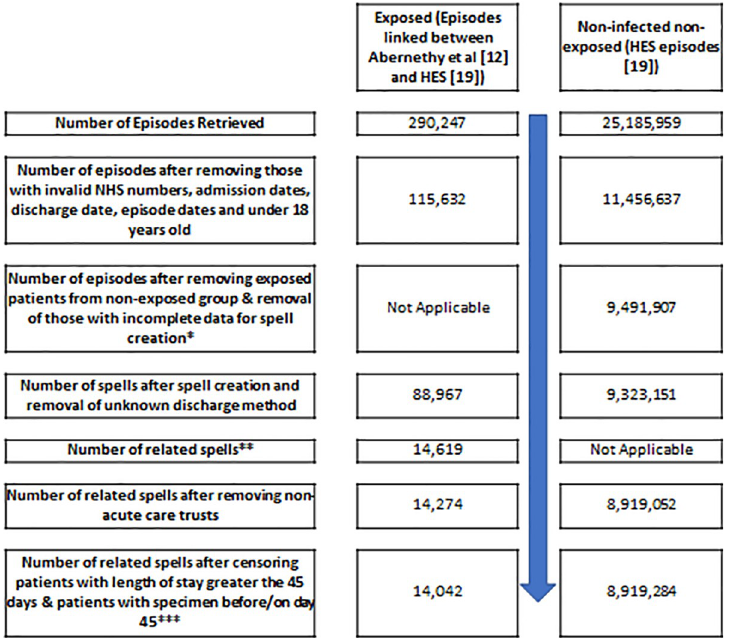
Fig 1. Linked dataset cleaning. � Variables needed for spell creation were HES identifier (‘extract_hesid’), admission date (‘admidate’), provider code, (‘procodet’), start of episode (‘epistart’), end of episode (‘epiend’) and method of discharge (‘dismeth’). �� The spell was coded as being related to the exposure if specimen was less 14 days before admission or occurred during admission. ��� Those that had not experienced infection prior to or on day 45 were treated as non-exposed patients and censored at day 45 (which causes the move of patients from exposed to unexposed category (n = 232)), this is due to our analysis being performed within the first 45 days of a patient’s hospital spell.